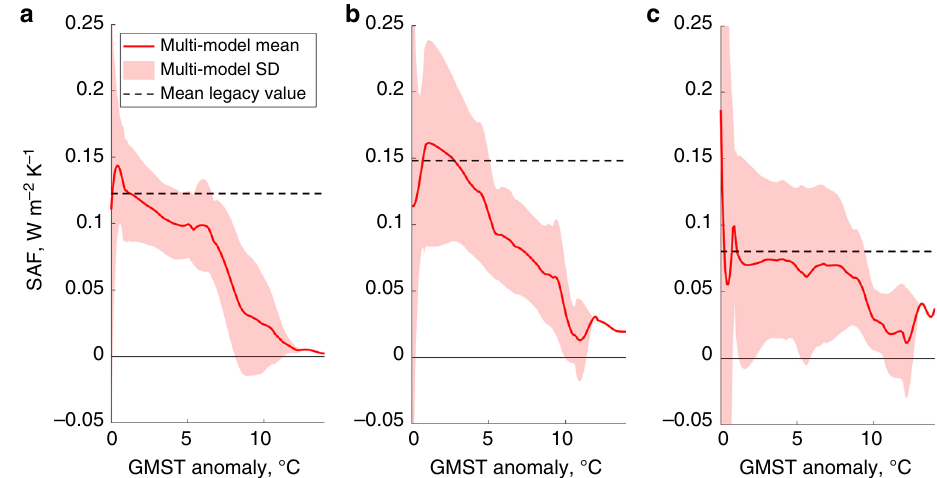
Fig. 2 Three components of the surface albedo feedback deduced from simulations of fully coupled climate models. SAF components (average global equivalent values) for a Arctic sea ice, b Northern Hemisphere land snow and c rest of the world, presented as functions of the GMST rise relative to pre- industrial conditions. Obtained from multiple CMIP5 GCMs using the ALL/CLR method. Solid red line: multi-model mean; shaded area: ±1 standard deviation (SD). Horizontal black dashed lines: legacy SAF forcing currently assumed in IAMs. Source data are provided as a Source Data fi le